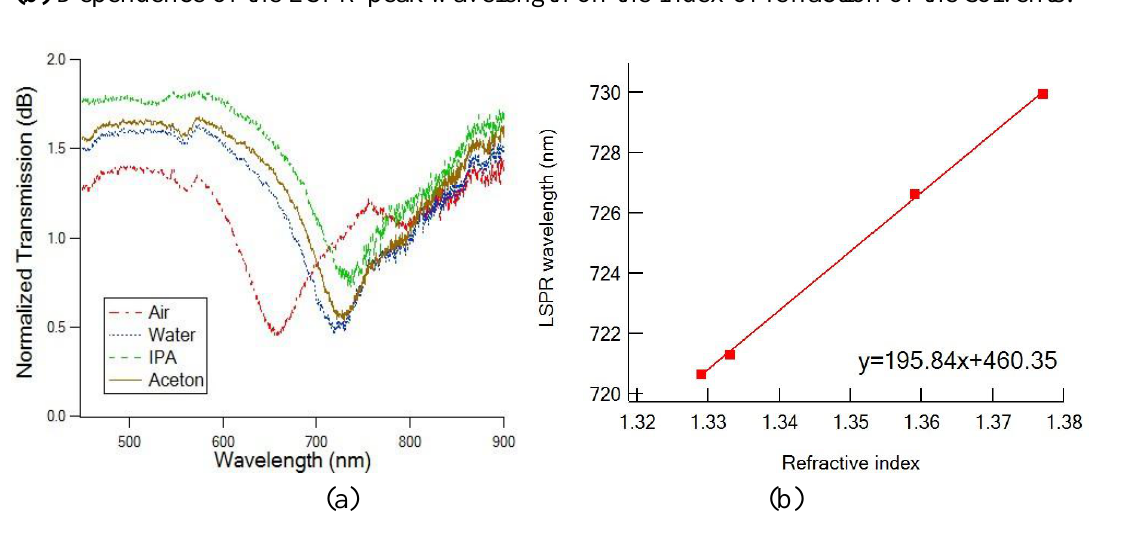
Figure 5. (a) Measured transmission spectra for the fiber sensor in various